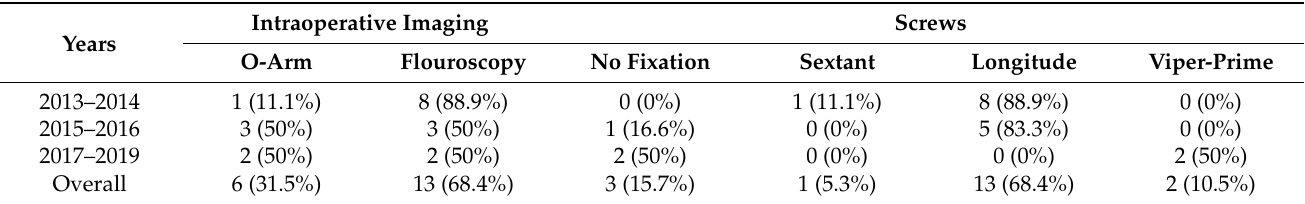
Table 3. Imaging and screw fixation advancements over the years in 19 patients with epidural spinal